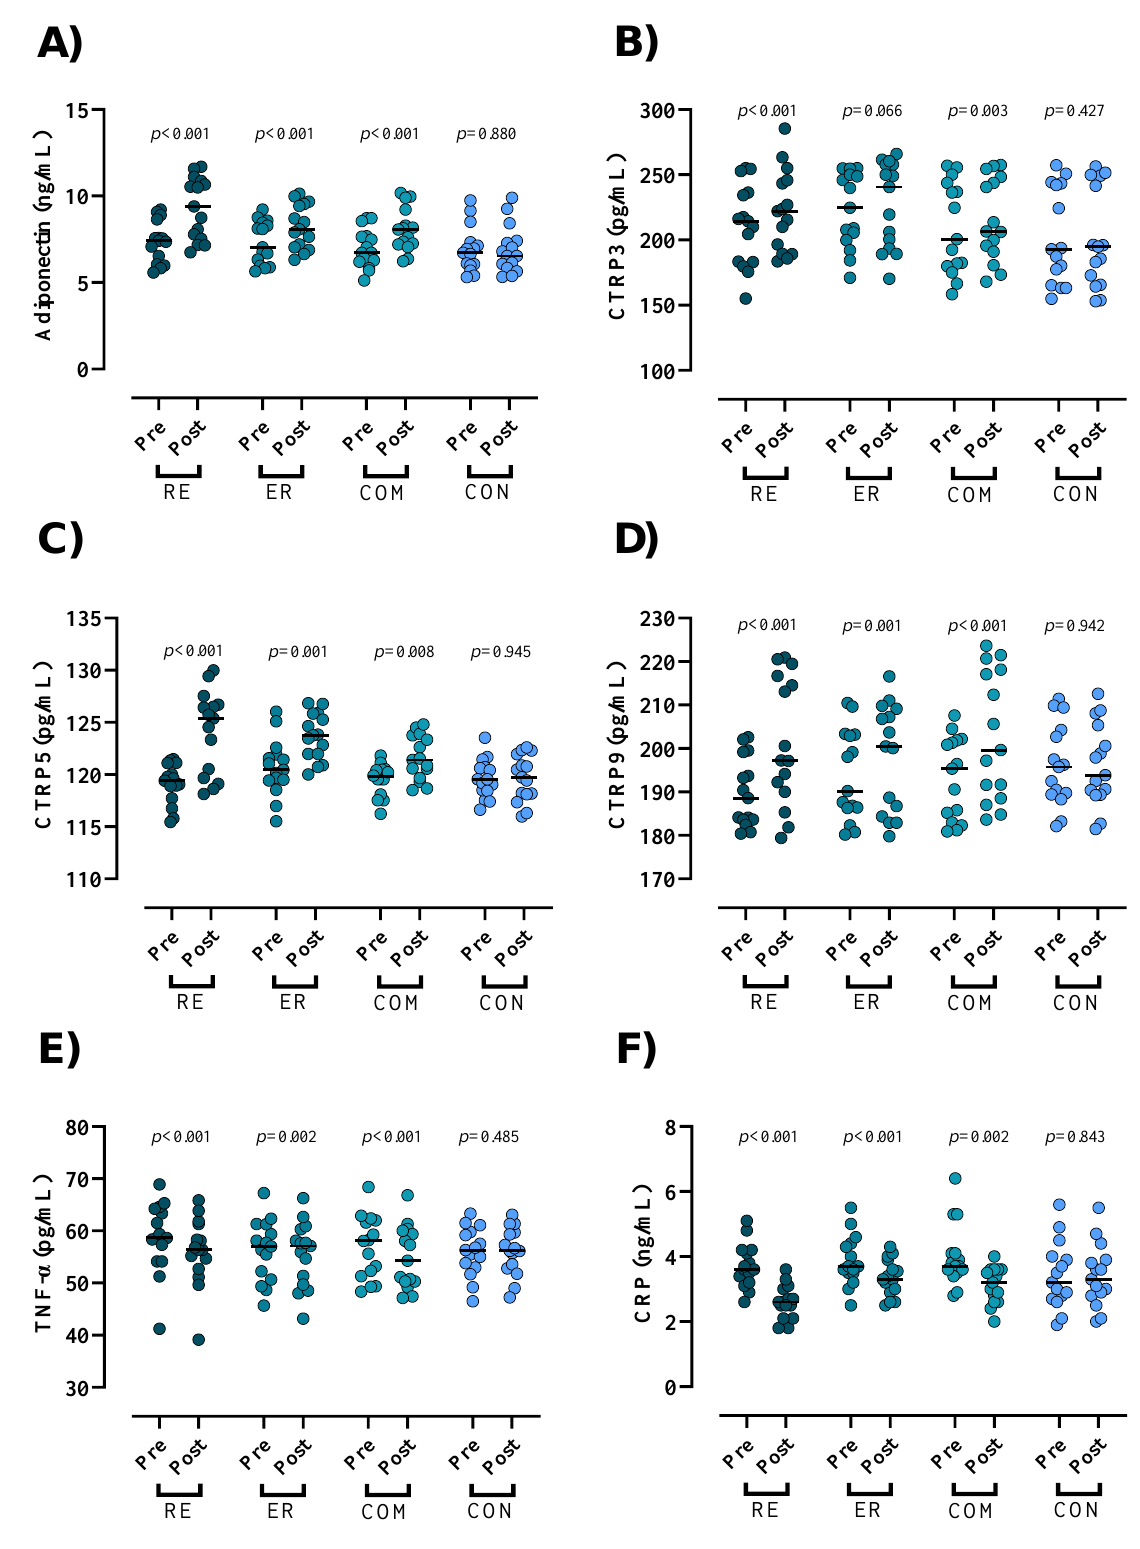
Figure 3. Effects of concurrent and combined training on changes in serum markers throughout the intervention: ( A ) adiponectin (ng/mL); ( B ) CTRP3 (pg/mL); ( C ) CTRP5 (pg/mL); ( D ) CTRP9 (pg/mL); ( E ) TNF- α (pg/mL); ( F ) CRP (ng/mL). n = 15 per group and p -values above time points indicate paired sample t -test